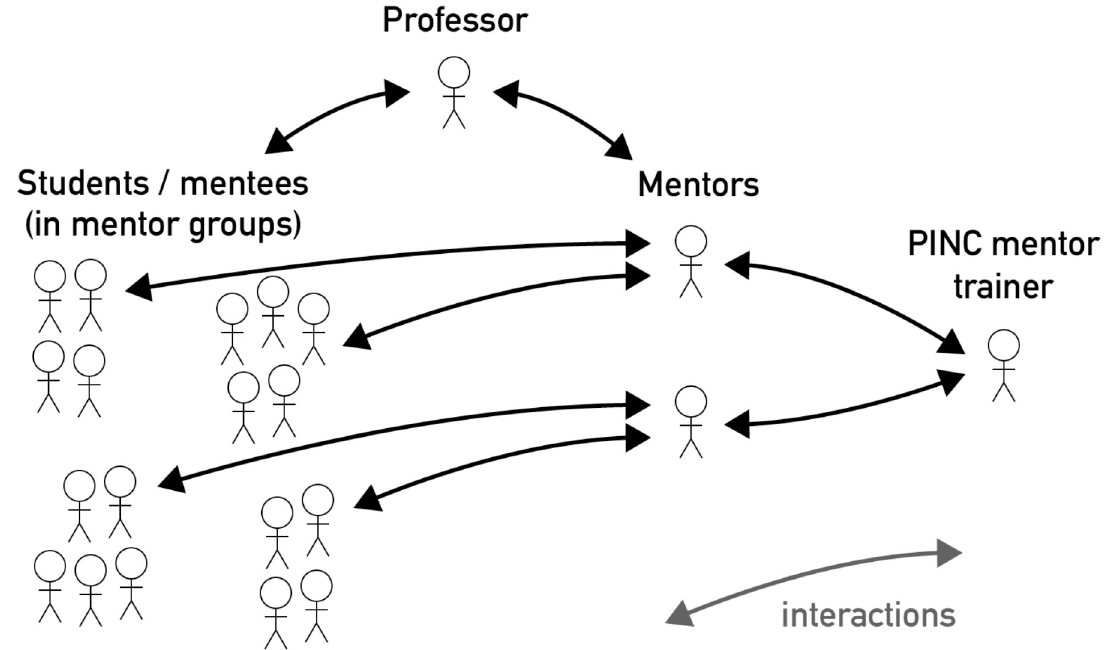
Fig 4. Important players in the PINC mentor program: professor, mentees, mentor, and mentor